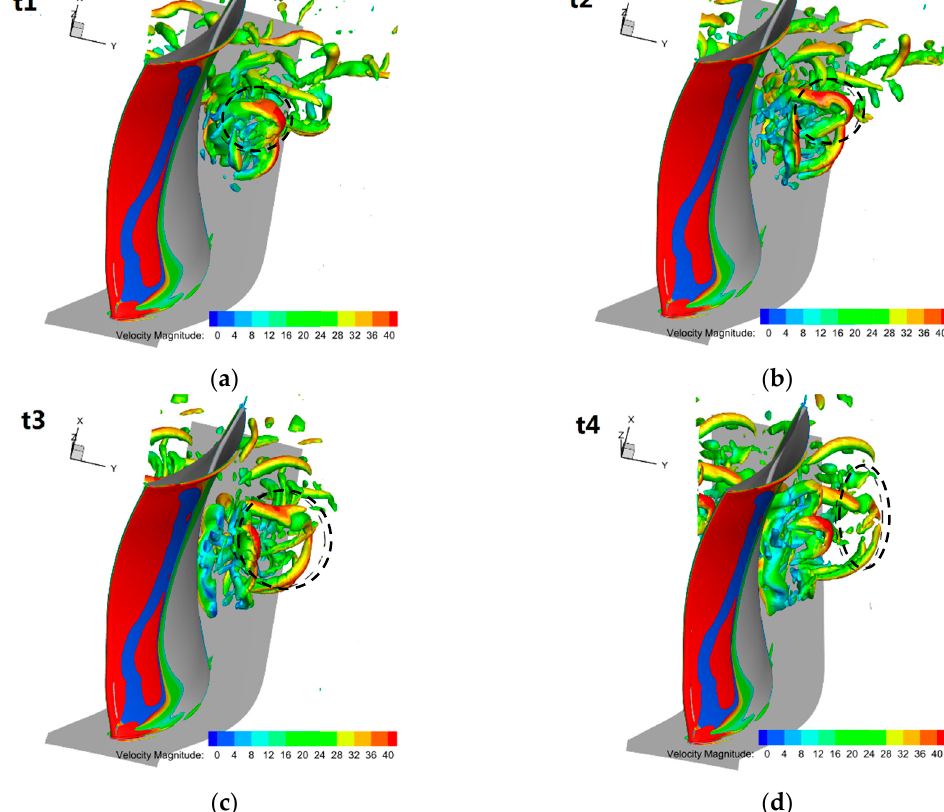
Figure 11. Isosurface of Q = 30,000,000 at different times: ( a ) t1; ( b ) t2; ( c ) t3; ( d ) t4.